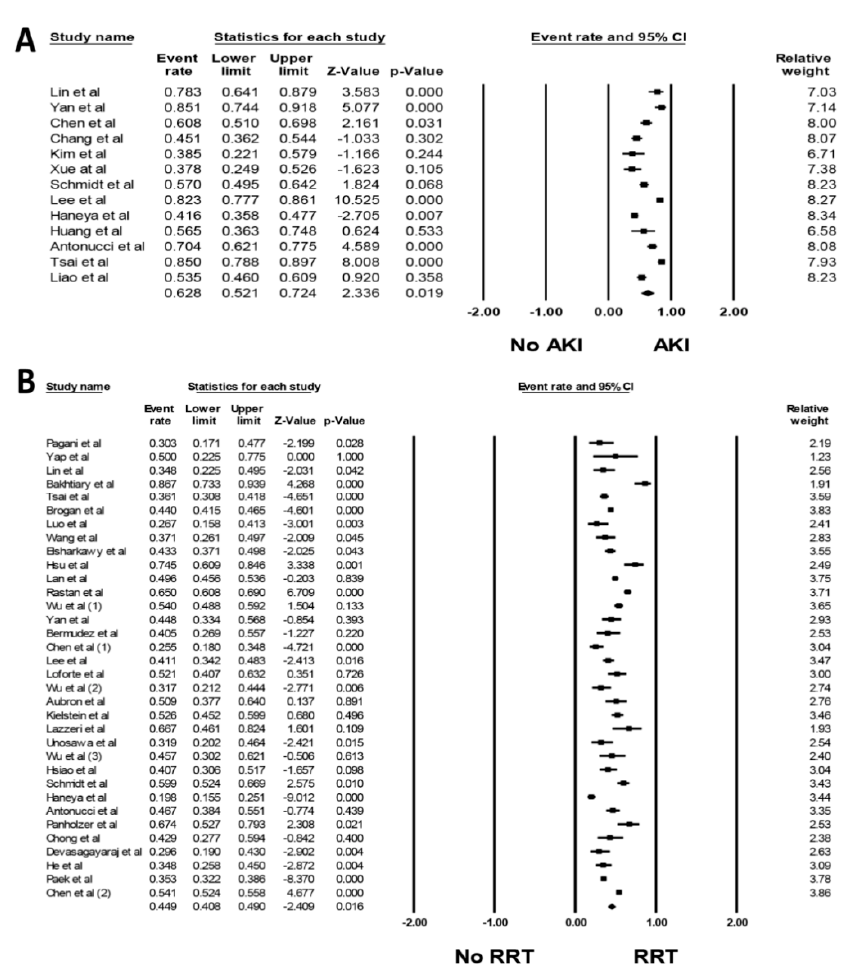
Figure 2. Forest plots of the included studies assessing ( A ) incidence rates of AKI while on ECMO and ( B ) incidence rate of severe AKI requiring RRT while on ECMO. A diamond data marker depicts the overall rate from each included study (square data marker) and 95%CI.